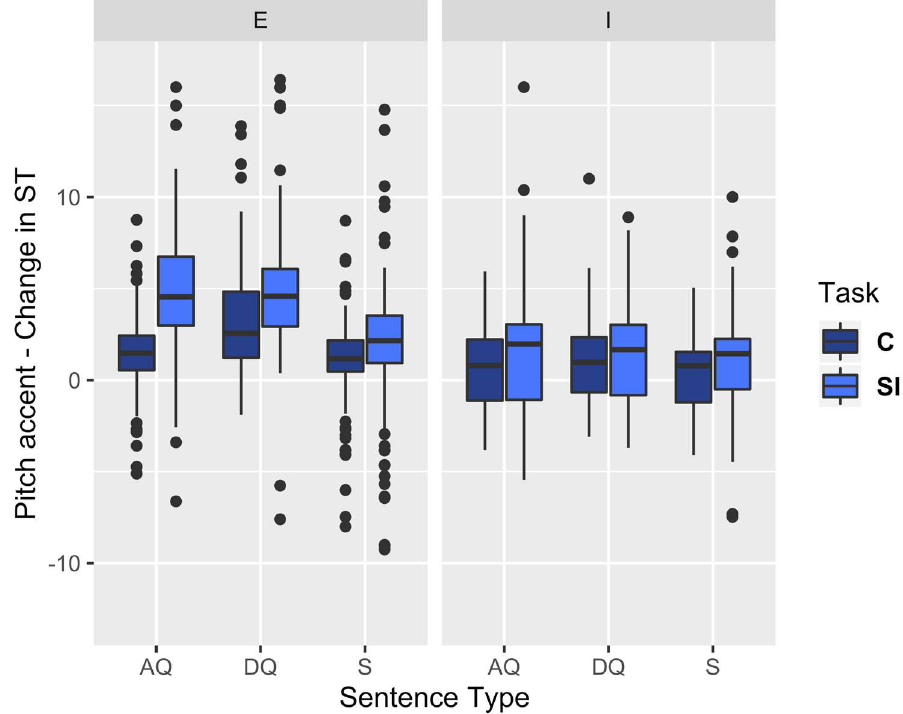
Figure 7. Boxplots displaying the pitch change (in semitones) over the first pitch accent in both tasks. Results organized by group. Table 9. (Pitch accents). Linear mixed effect model with Language, Task and Sentence Type as fixed